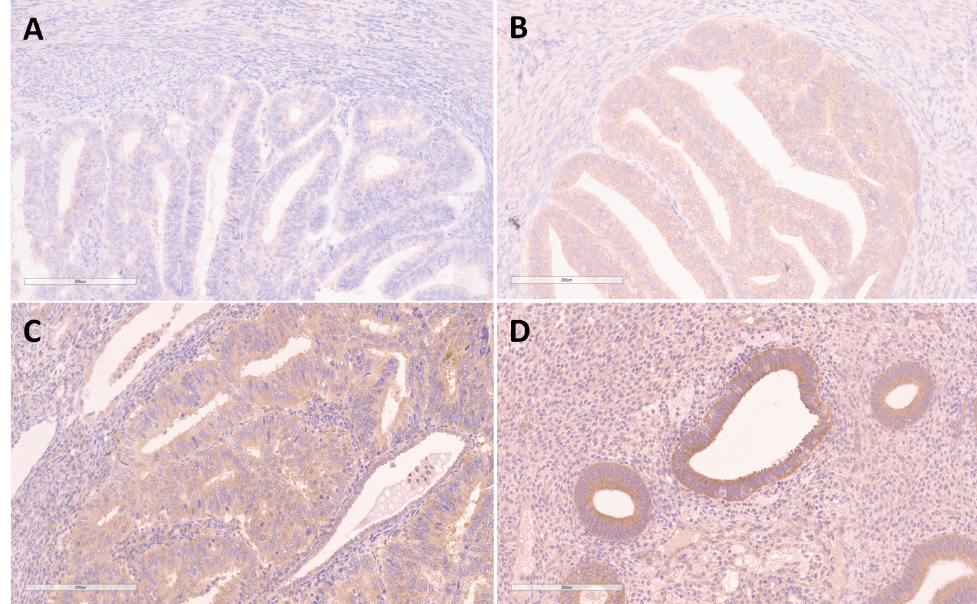
Figure 1. Immunohistochemical staining for FKBPL in endometrioid endometrial carcinoma showing no expression—0 ( A ), low expression—1 ( B ), moderate expression—2 ( C ), and immunohistochemical staining for FKBPL in benign endometrial hyperplasia showing high expression—3 ( D ). Magnification ×200.